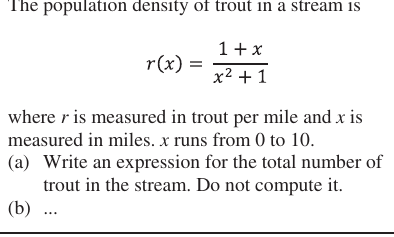
FIG. 2. A final exam problem from an introductory calculus